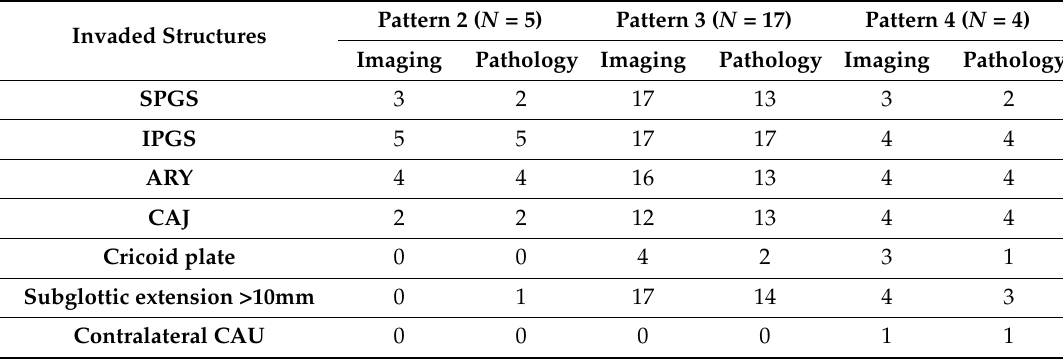
Table 3. Comparison between imaging and pathological evaluation